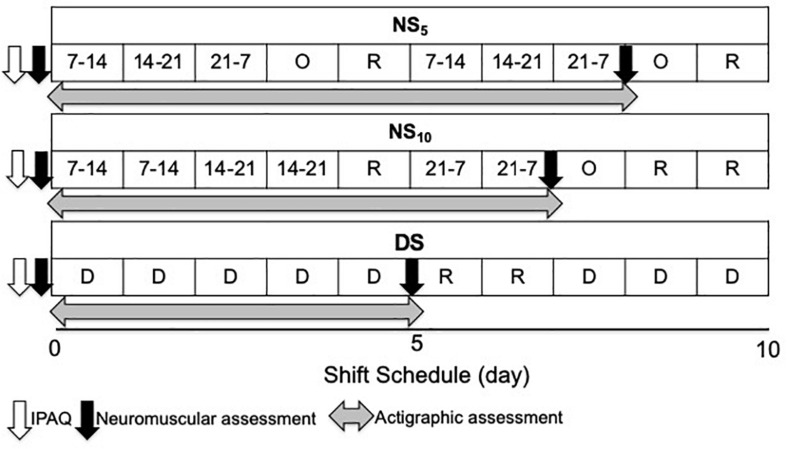
Study flow chart. NS5, 5-day night shift; NS10, 10-day night shift; DS, day/swing shift; O, night off; R, rest; D, day.